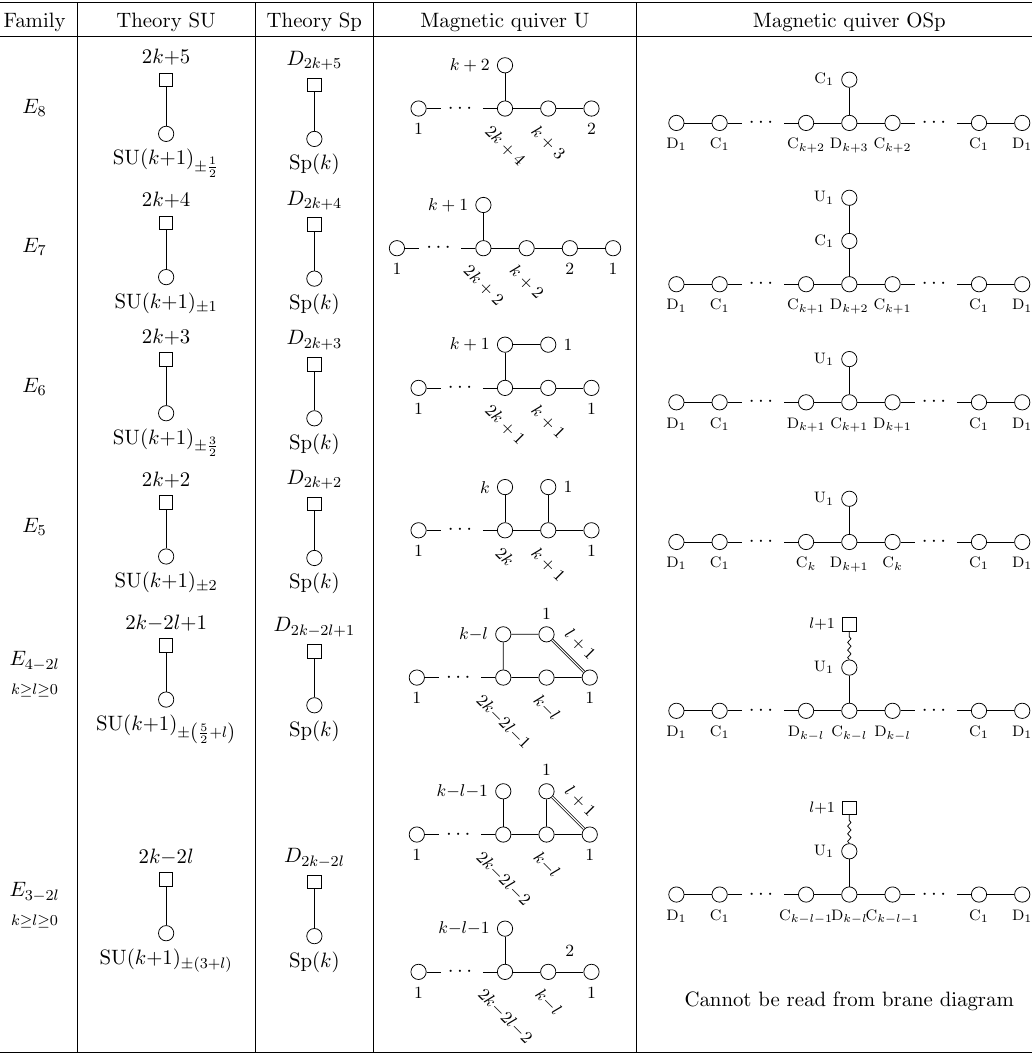
Table 1 . Magnetic quivers at in(cid:12)nite coupling. The 5d = 1 duality between \Theory SU" and N \Theory Sp" has been observed in [16], also [18]. The wiggly link denotes a charge 2 hypermultiplet. The \Magnetic quiver OSp" are derived in section 3, while \Magnetic Quiver U" are subject of section 4. For k = 0, the moduli spaces are free hypermultiplets transforming as spinors of the global symmetry. The \Magnetic quiver OSp" for E 8 ; 7 ; 6 can be obtained from class S [78, 79]. Concerning orthogonal or symplectic gauge theories without complete Higgsing, (cid:15) the magnetic quivers provide predictions on the (cid:12)nite and in(cid:12)nite coupling Higgs